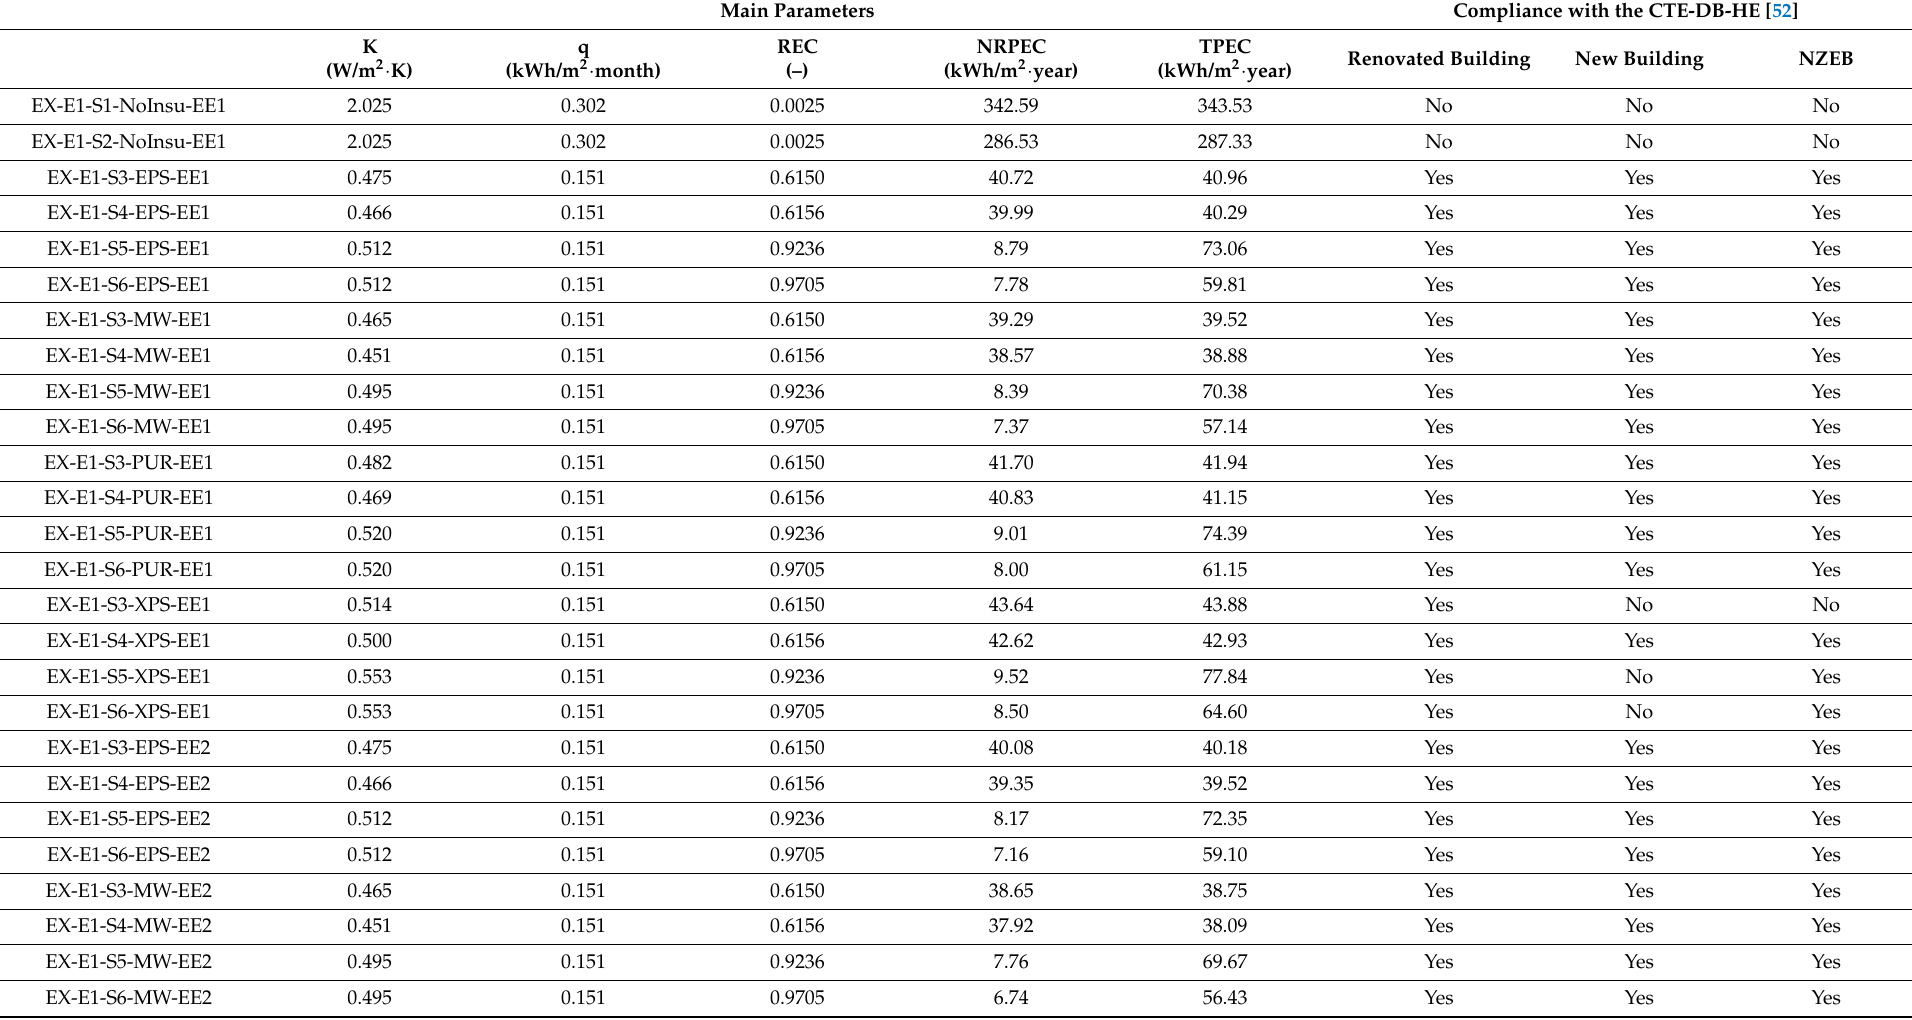
Table A3. Verification of compliance with the CTE-DB-HE [52] for each case study in San Mill á n de la Cogolla (CCZ EX-E1). Main